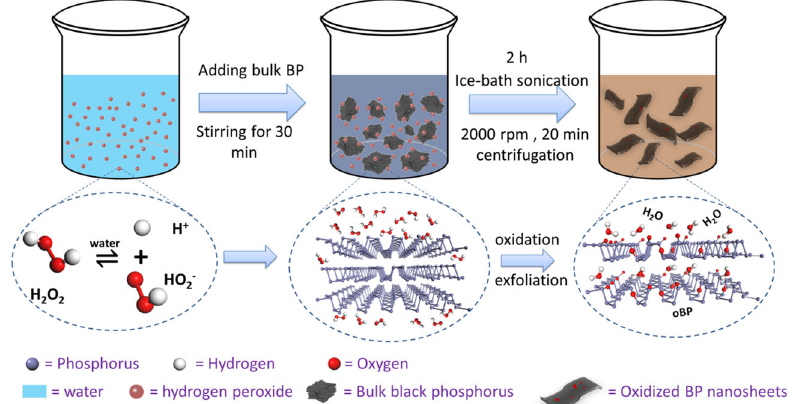
Fig. 1 Schematic illustration. Schematic illustration of the synthesis process of the suspension with partially oBP